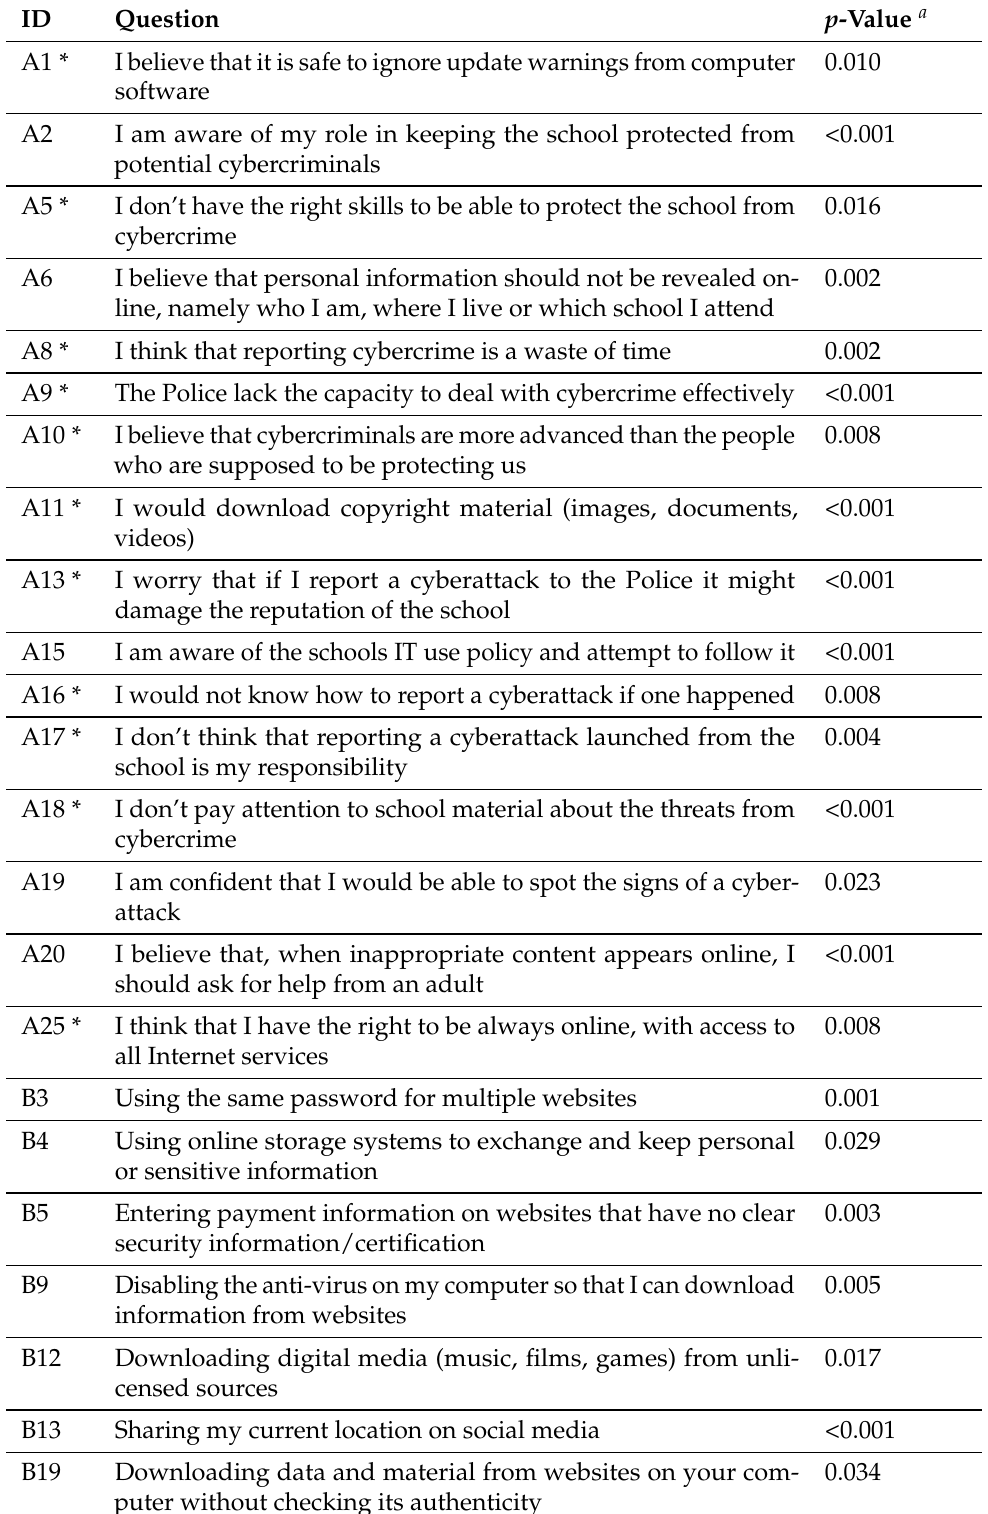
Table 4. Cybersecurity Attitudes and Behavior questions where significant differences were found between